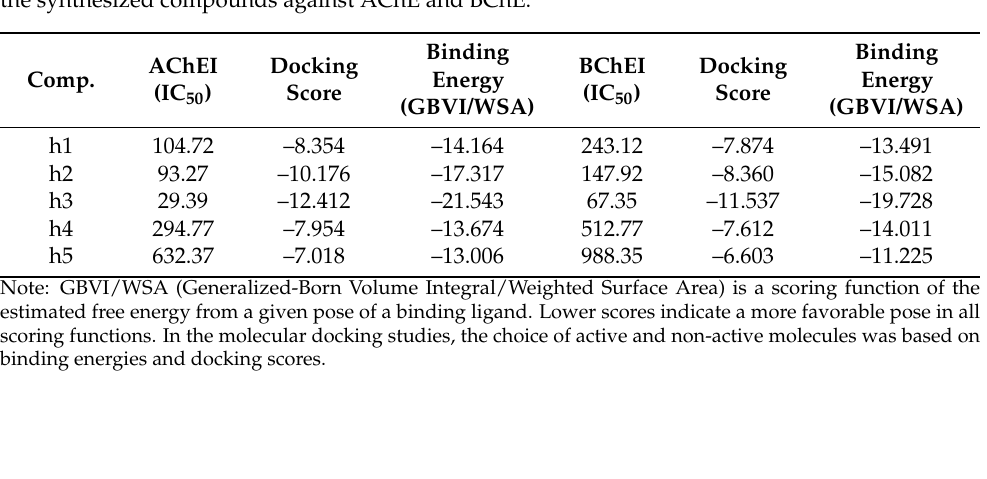
Table 1. Compound codes, molecular structures, IC 50 values, docking scores and binding affinity of the synthesized compounds against AChE and